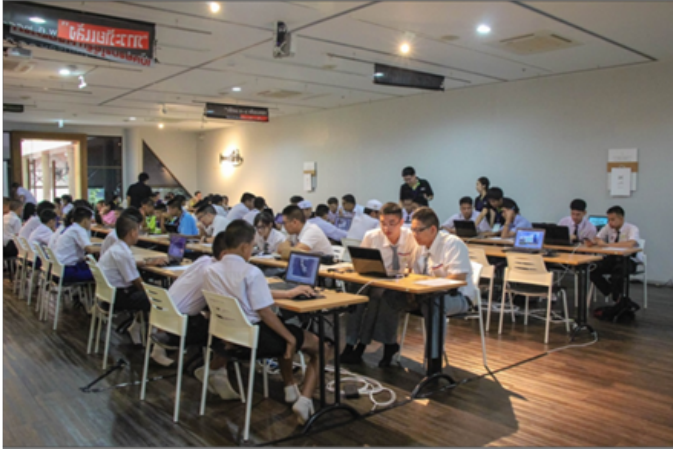
Fig. 2. Participants of Eco challenge 2017 in Chiangmai